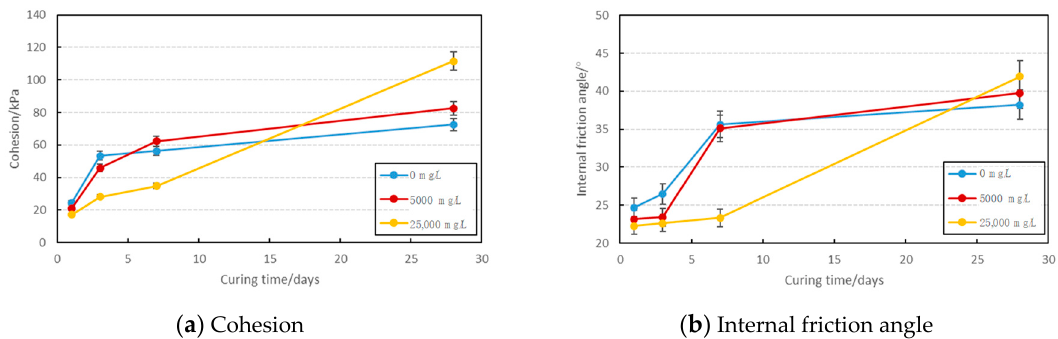
Figure 16. Evolution of the shear strength parameters of the FR ‐ CPB/rock interface with sulfate concentration under the effect of treatment time (CPB made with 0.3% fibers).